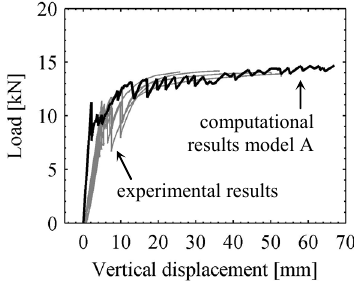
Figure 6: Combined load-displacement diagrams of the computational model A and the experimental